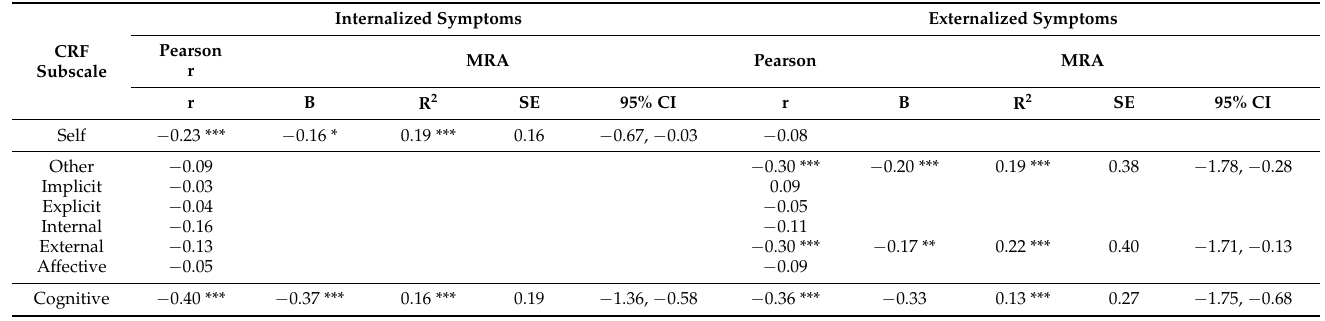
Table 6. Pearson correlation between CRF dimensions with Internalized and externalized psy- chopathology symptoms and stepwise MRA results after controlling age and